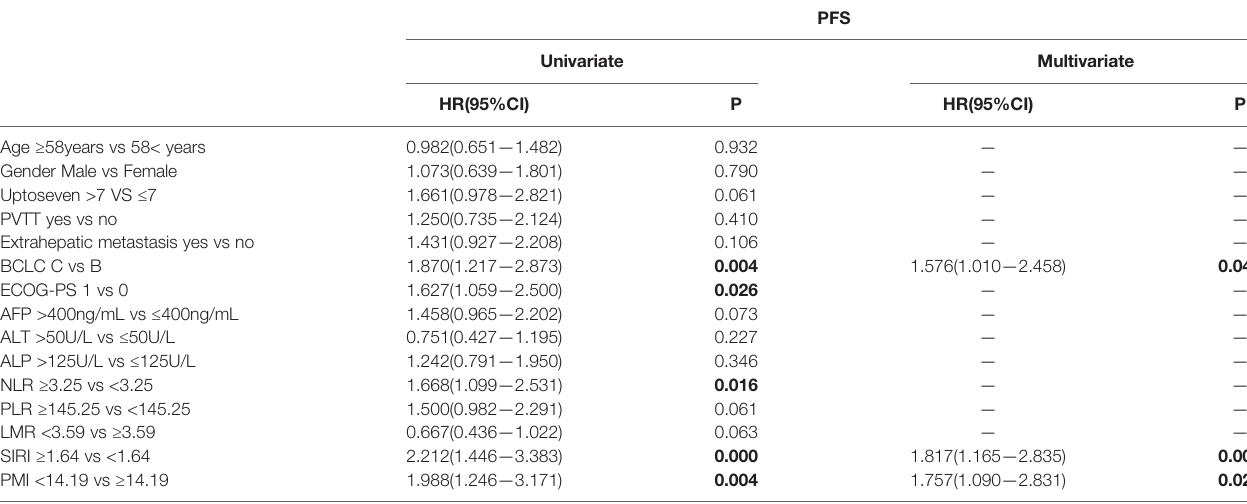
TABLE 3 | Prognostic factors for progression-free survival.